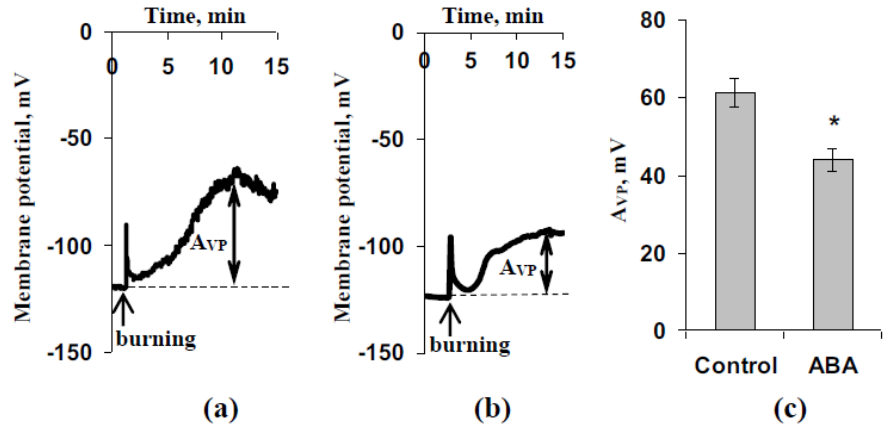
Figure 4. ( a ) Microelectrode record of burning-induced variation potential (VP) in the leaf of a control pea seedling. ( b ) Microelectrode record of burning-induced variation potential (VP) in the leaf of a seedling 1 day after the ABA treatment. (c) Average amplitudes of VP in control seedlings and seedlings after the ABA treatment ( n = 5). The ABA treatment of seedlings was performed by spraying them with aqueous solutions (10 − 5 M) 1 day before electrical measurements; control plants were treated with equal volumes of water. Electrical measurements were performed in the second mature leaf. Variation potentials were induced (burning of the first mature leaf by a flame, 3-4 s, about 1 cm 2 ) 1.5 h after plant fixation for measurement. A VP was calculated as the di ff erence between maximal and initial values of the membrane potential. *, di ff erence between experiment and control plants is significant ( p < 0.05).